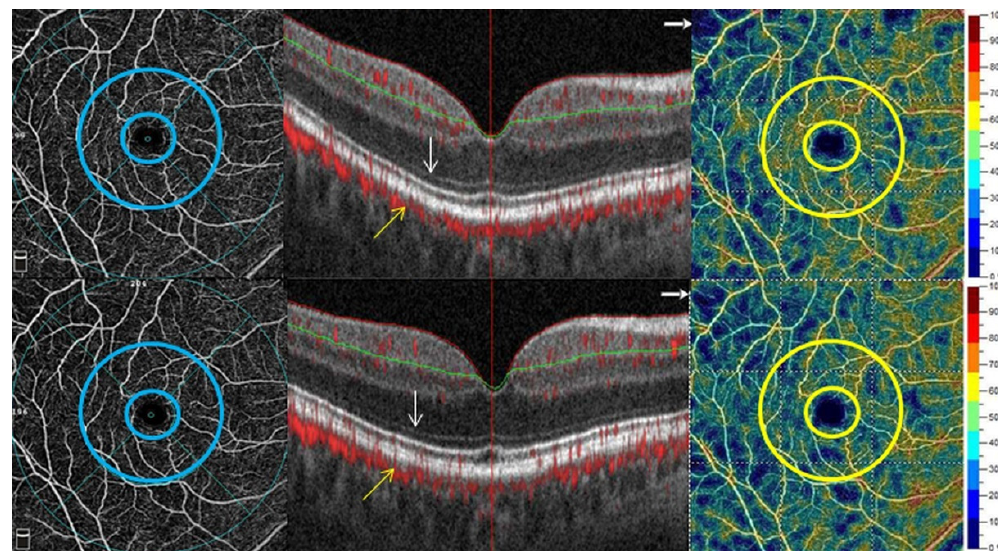
Figure 1. Optical coherence tomography angiography (OCTA) and capillary perfusion density analysis. Legend: Top row: Left, example of en face OCTA of rheumatoid arthritis patient. The foveal area is identified by a circle 1 mm in diameter centered on the fovea, the parafoveal region is included between the two concentric circles of 1 mm diameter and 3 mm diameter; center, structural optical coherence tomography, showing the complete integrity of the layers and flow signals; right, full retina capillary vessel density analysis. Bottom row: No changes in the retinal architecture and vessel density at one-year follow-up can be seen, compared with baseline images; in particular, the integrity of the retinal inner and outer segments (white arrow) and retinal pigment epithelium (yellow arrow) are well represented; in parallel, no significant change in the vessel density may be observed within 1 and 3 mm circles.